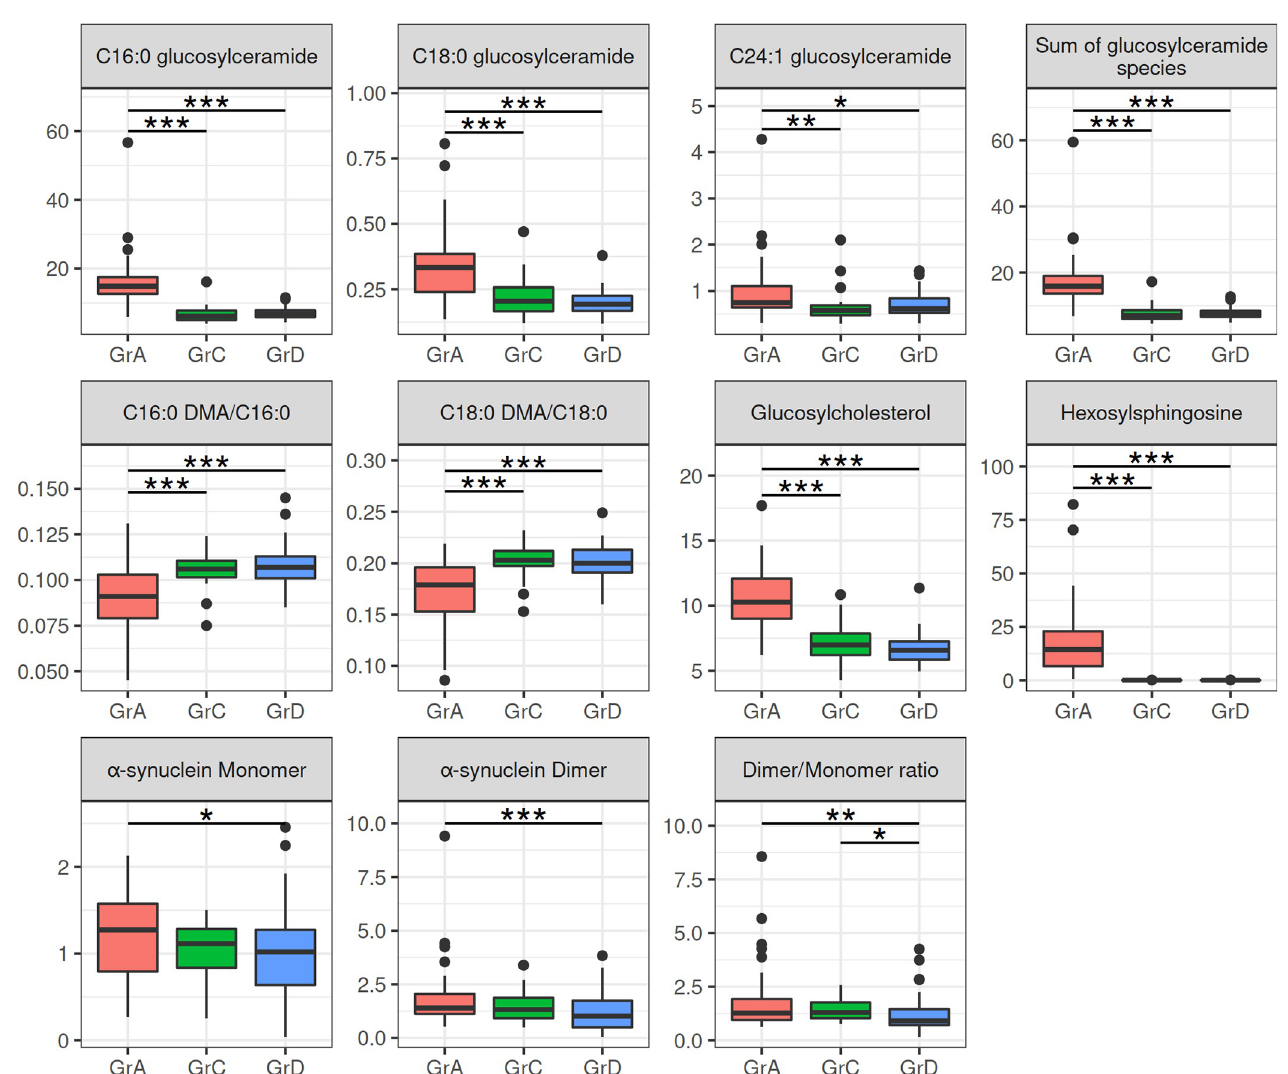
Fig 2. Red blood cell membrane levels and statistical comparison of the lipids and of α -Synuclein species studied in Gaucher disease patients receiving no treatment, Gaucher disease carriers and controls. C16:0-glucosylceramide: N-palmitoyl-glucosylceramide; C18:0-glucosylceramide: N-stearoyl- glucosylceramide; C24:1-glucosylceramide: N-nervonoyl-glucosylceramide; C16:0 DMA/C16:0, C16:0-plasmalogens; C18:0 DMA/C18:0, C18:0-plasmalogens; GrA, Gaucher disease patients receiving no treatment; GrC, Gaucher disease carriers; GrD, controls. Y-axis: the C16:0-, C18:0- and C24:1- glucosylceramide species, their sum, hexosylsphingosine and glucosylcholesterol are expressed in pmoles/10 8 cells. The C16:0- and C18:0-plasmalogens are expressed as the ratios of C16:0 DMA to C16:0 and C18:0 DMA to C18:0, respectively. The α -synuclein monomer and dimer are expressed as the ratio of monomeric and dimeric α - Syn to GAPDH, respectively. The α -synuclein dimer/monomer ratio is expressed as the ratio of dimeric to monomeric α -Syn normalized against a reference sample, the dimer to monomer ratio of which was set as 1. � p < 0.050, �� p < 0.010, ��� p < 0.001. Data were analyzed using Kruskal-Wallis test, with Dunn’s post hoc